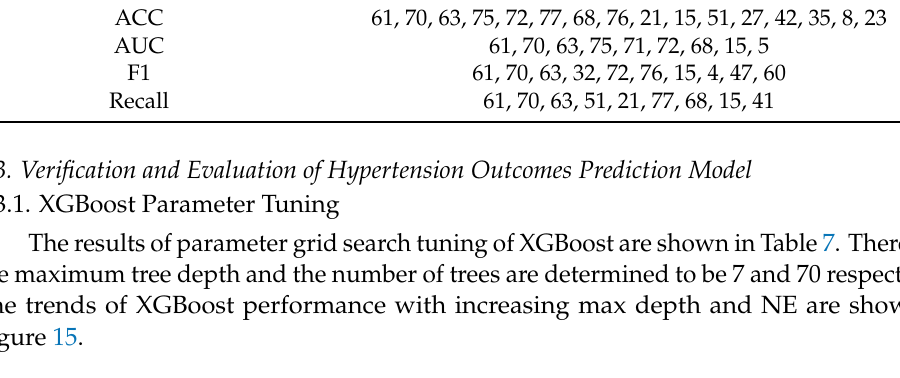
Table 6. Feature combination by GSFTS-FS.